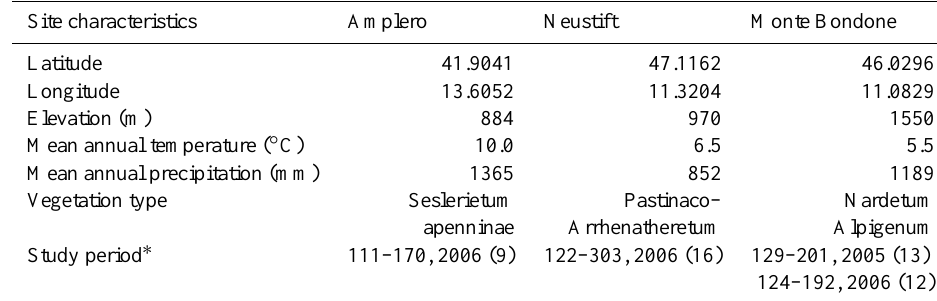
Table 1. Description of the study sites and